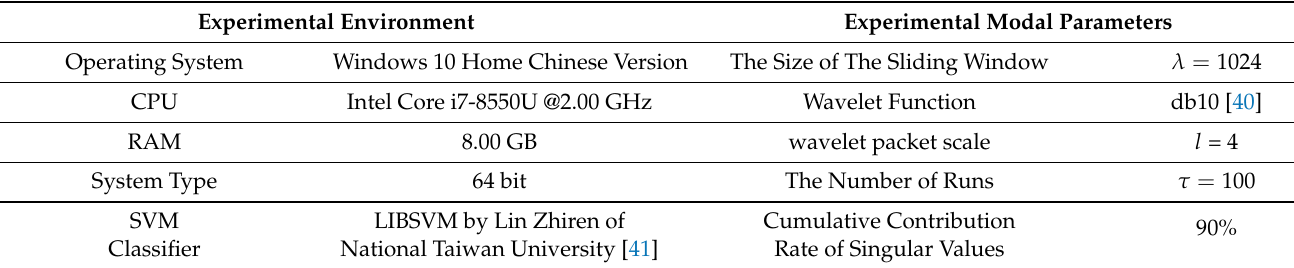
Table 2. Experimental Environment and Parameters.